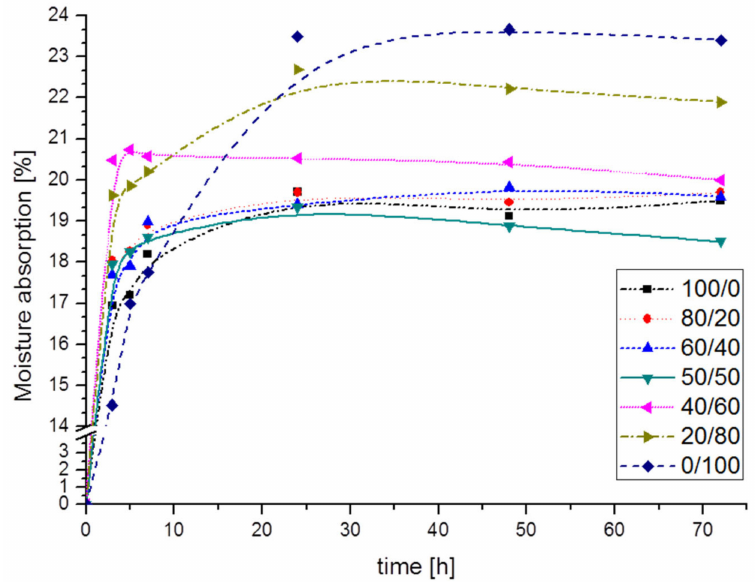
Figure 7. Moisture absorption of CMS / CMC